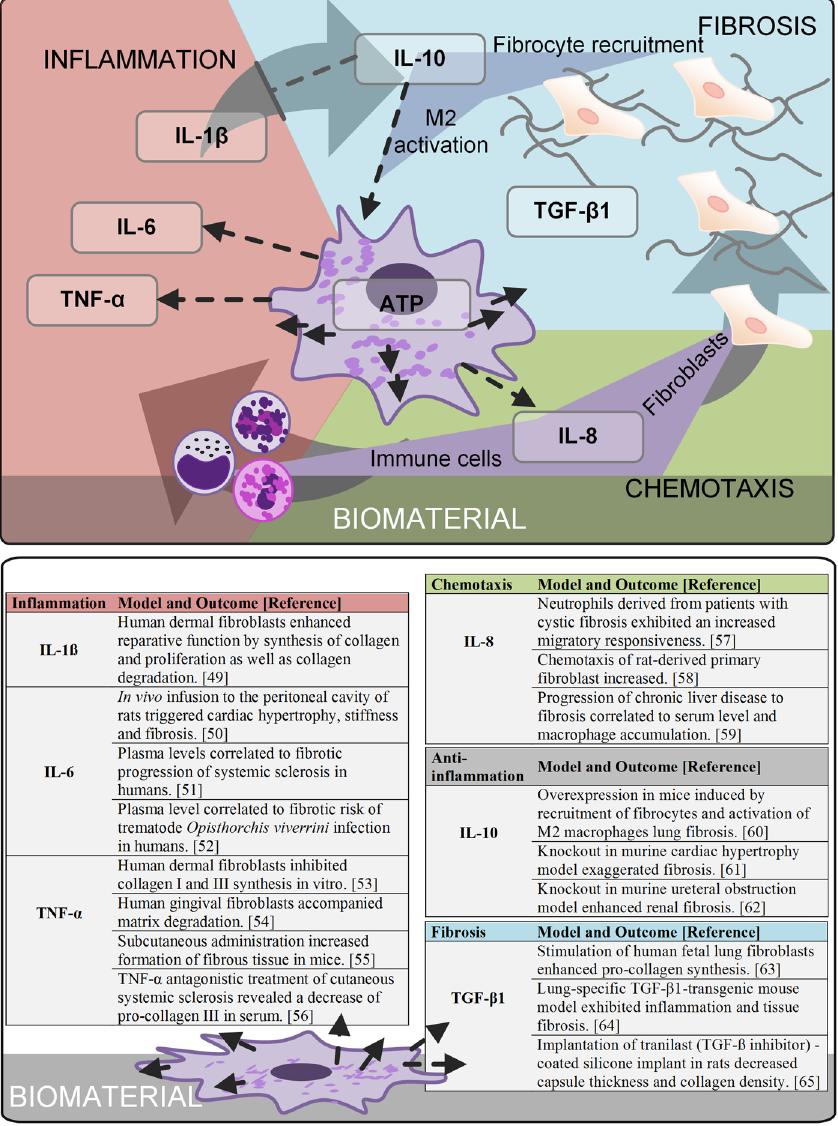
Figure 2. To characterize materials’ fibrotic potential, the influence of the selected test conditions on the net secretion of cytokines was investigated. All selected readout factors represent fibrotic drivers: a strong cellular viability on materials’ surface maintains a chronic responsiveness to the foreign body; a pro-inflammatory component at the initial stage of cell-implant contact induces a fibrotic progression and a chemokine gradient guiding further cells to implant region strengthens both the inflammatory and fibrotic response. Despite the mechanism of surface-induced cytokine secretion and their influence to final fibrotic progression is poorly understood, pre-clinical and clinical studies from adjacent research areas substantiate the selection of readout